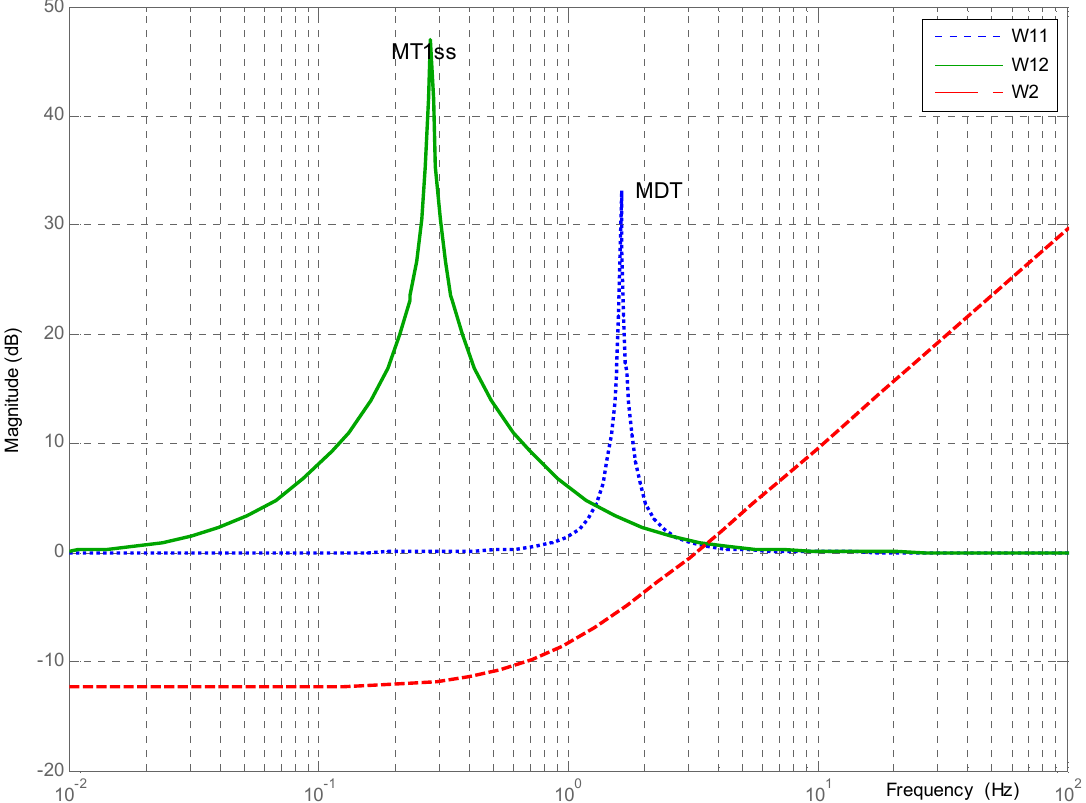
torque controller ∞